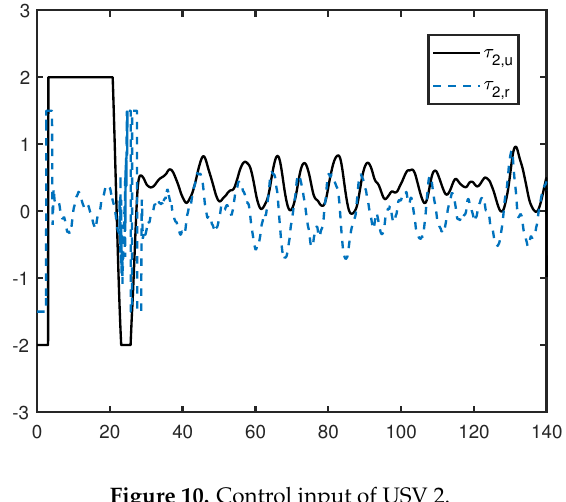
Figure 10. Control input of USV 2.